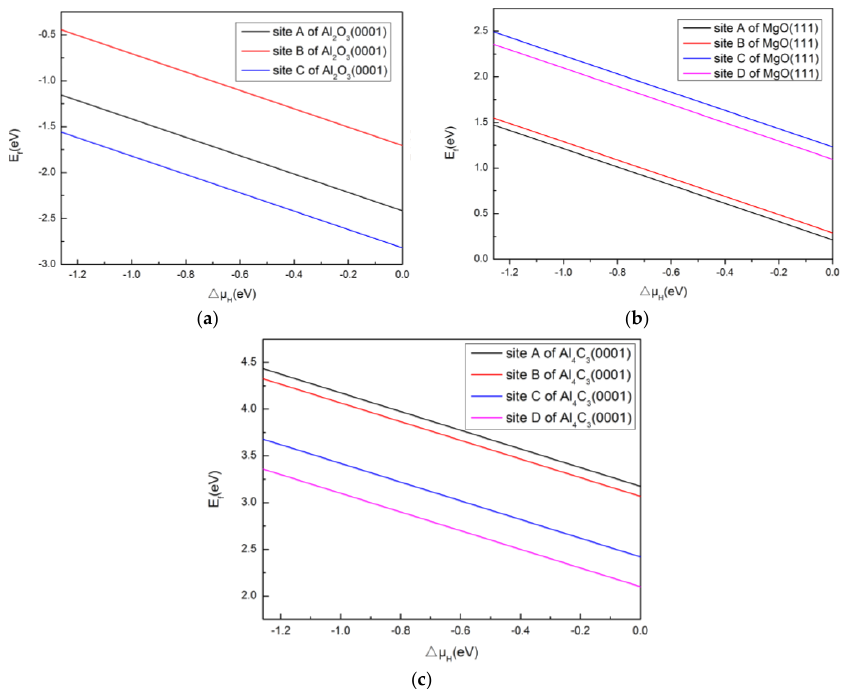
Figure 5. Formation energy of H adsorption on ( a ) Al 2 O 3 (0001), ( b ) MgO(111) and ( c ) Al 4 C 3 (0001) as function of the relative chemical potential of H.